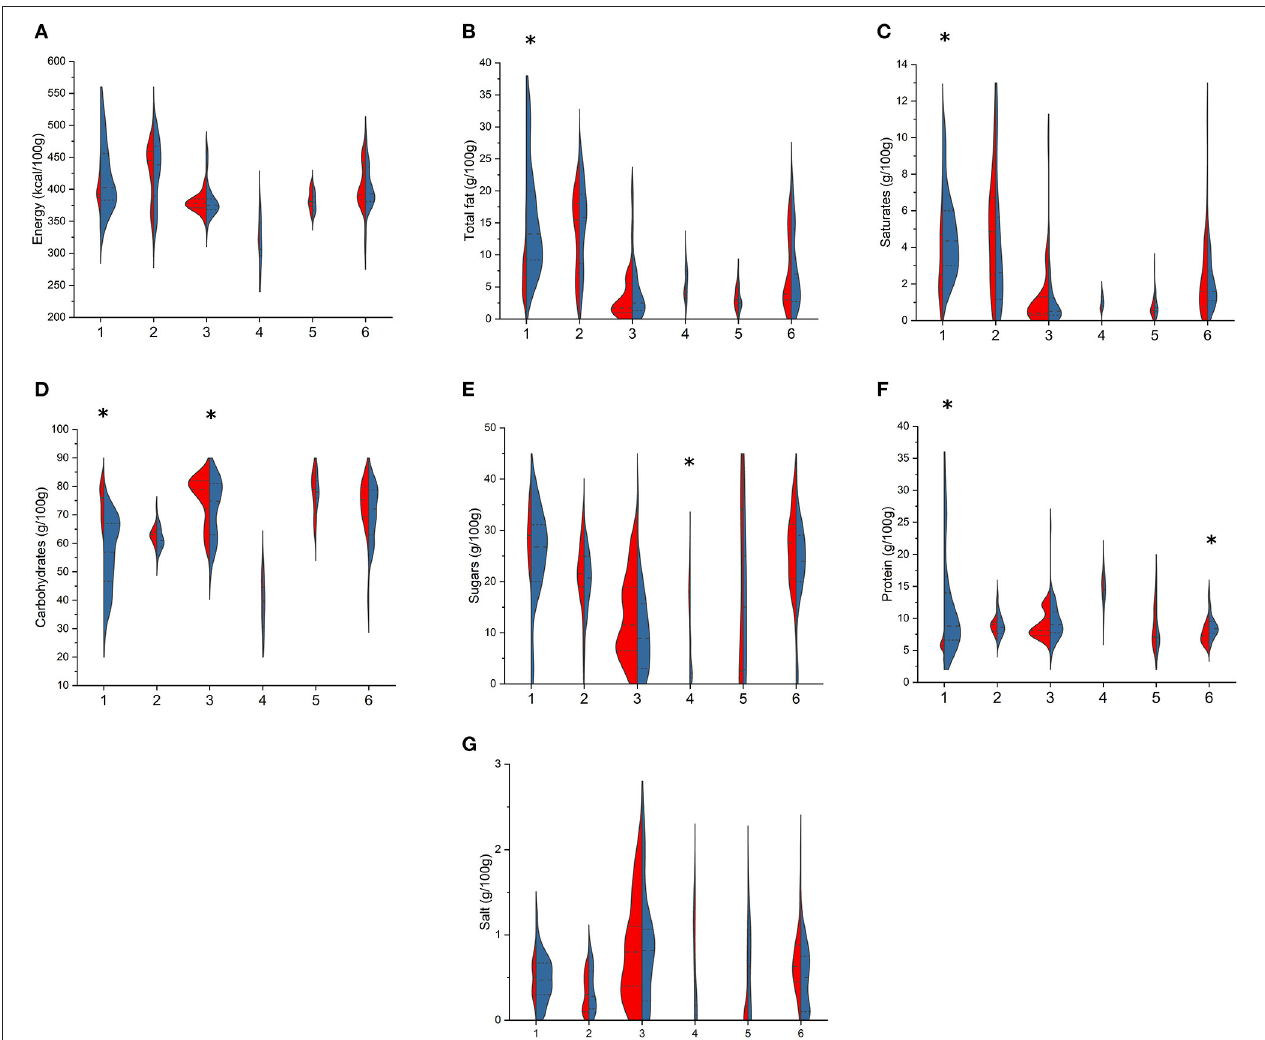
FIGURE 1 | Comparison of energy (A) , total fat (B) , saturates (C) , total carbohydrates (D) , sugars (E) , protein (F) , and salt (G) content in branded (BR, in blue) and private-label (PL, in red) types of breakfast cereals. 1: cereal bars; 2: muesli; 3: flakes; 4: bran cereals; 5: puffed cereals; 6: other cereals. For each type, asterisk indicates significant difference between BR and PL items (Mann–Whitney non-parametric test for two independent samples), p < 0.05.